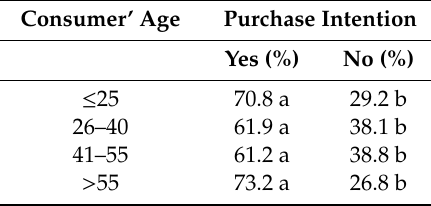
Table 5. The percentages for purchase intention of pork from in function of consumer’ age.